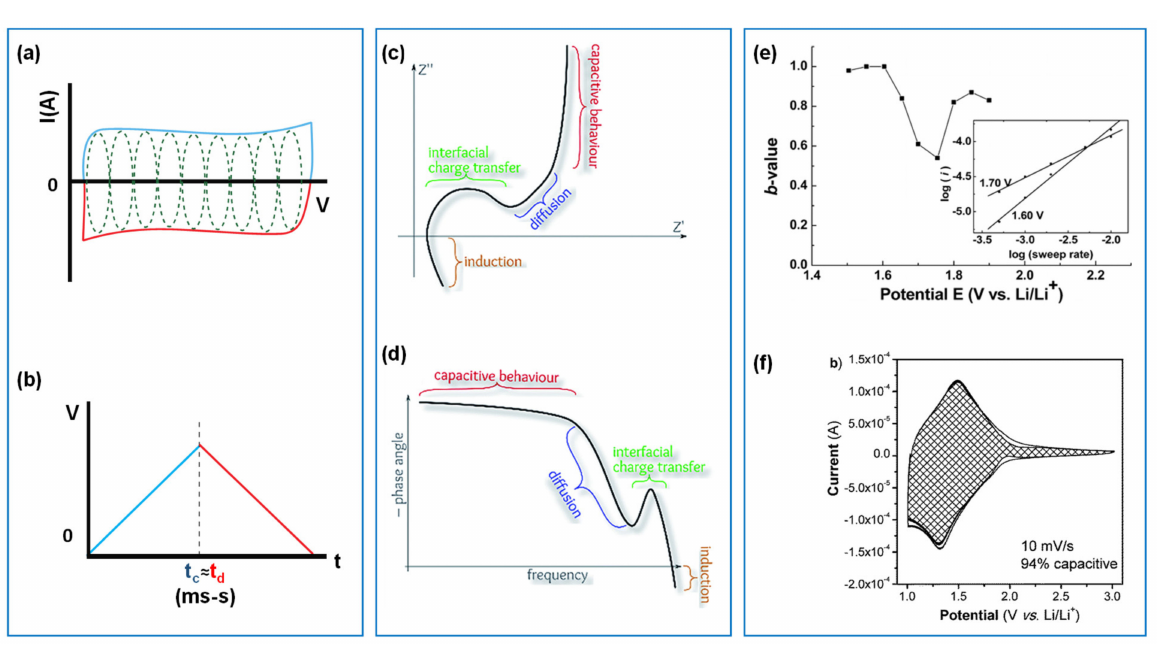
Figure 1. ( a , b ) CV and GCD profiles, ( c , d ) Nyquist and Bode plots of capacitive materials, and ( e , f ) Kinetics analysis of the electrochemical response: b -values and deconvoluted CV profile for intercalating pseudocapacitive materials, reproduced with permission from Refs.